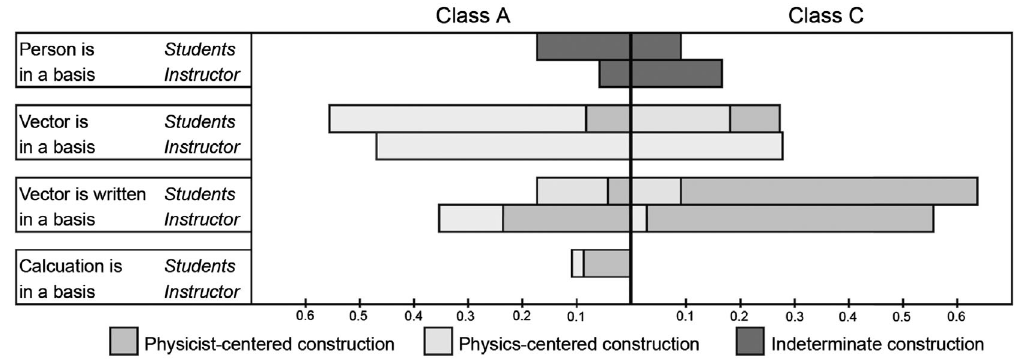
FIG. 2. Proportion of students ’ and instructors ’ discourse referring to entities in a